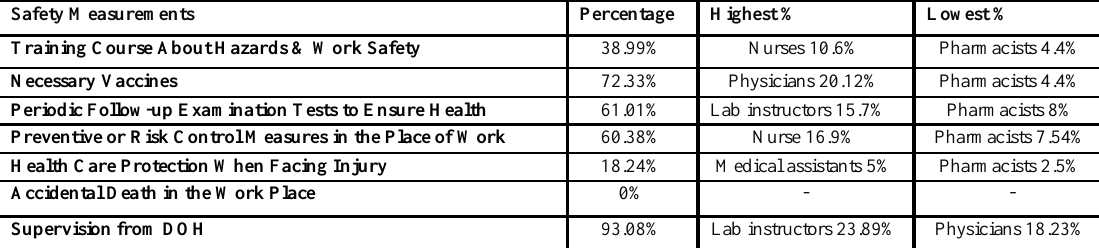
Table 2. Safety measurements of the study sample